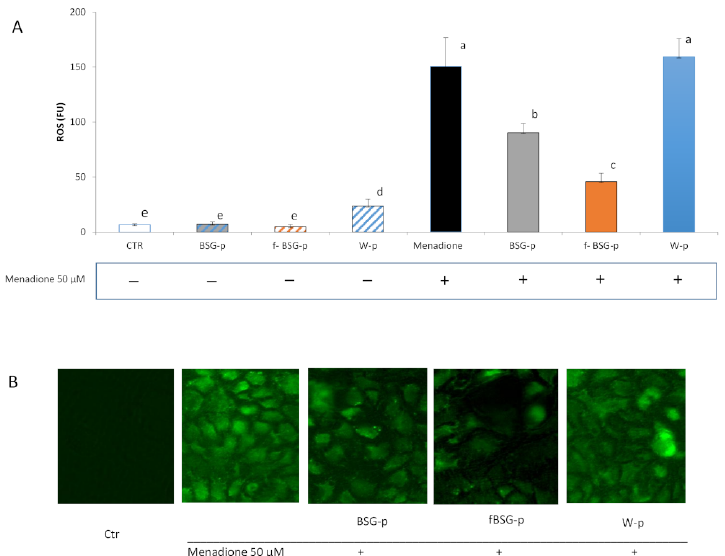
Figure 5. Intracellular reactive oxygen species (ROS) (fluorescence intensity units, FU) ( A ) and representative fluorescent microscopic images ( B ). Green fluorescent signal denotes ROS detection by the CellROX®Green reagent. ROS induction was detected utilizing CellROX®Green reagent coupled with the SpectraMax®MiniMax™ Imaging cytometer as described in the Materials and Methods. Caco-2 cells were treated with wheat pasta (W-p), pasta containing native (BSG-p), and fermented (fBSG) brewers’ spent grain (BSG) or not treated (Ctr). To induce oxidative stress, Caco-2 cells were treated with 50 µ M Menadione. Data are the means ( ± SD) of three independent experiments analyzed in triplicate. Data were subjected to one-way ANOVA followed by Tukey’s procedure at p < 0.05. Bars with different superscript letters differ significantly ( p <